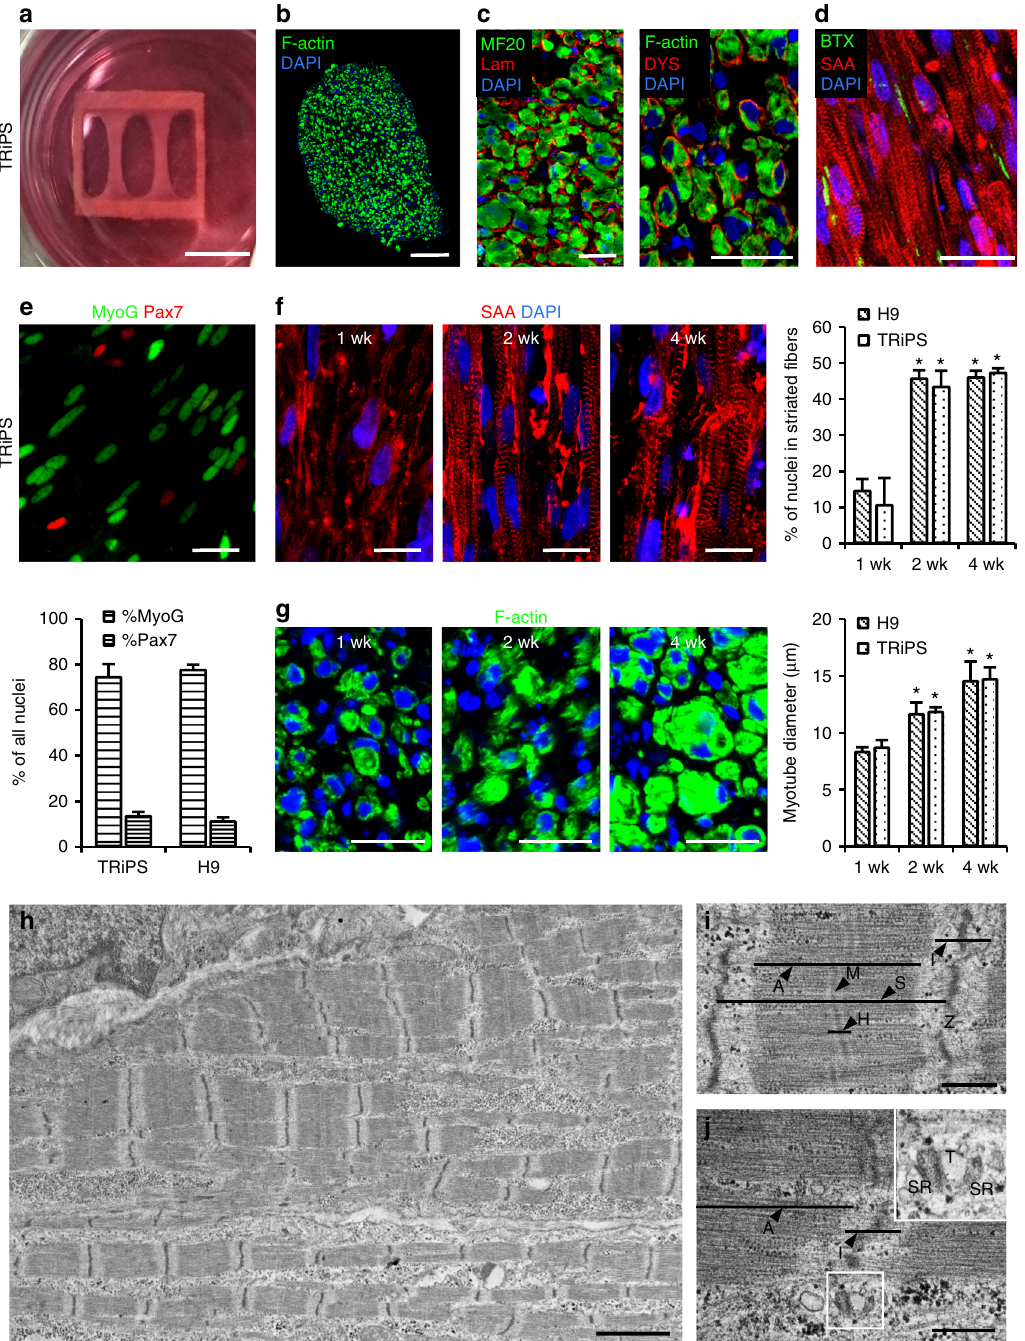
Fig. 3 Structure of hPSC-derived iSKM bundles. a A 2-week differentiated iSKM bundle pair anchored within a nylon frame. Scale bar = 5 mm. b , c Representative immunostaining of dense, uniformly distributed, myotubes in bundle cross-section. Scale bars: ( b ) 75 µ m, ( c ) 25 µ m. Lam laminin, DYS Dystrophin. d Representative longitudinal section of 2-week differentiated bundles showing aligned, cross-striated myotubes with α -bungarotoxin (BTX) labeled acetylcholine receptors. Scale bar = 25 µ m. e Immunostaining and quanti fi cation of Pax7 + and MyoG + nuclei in 2-week H9 and TRiPS bundles ( n = 3 bundles for each cell line). Scale bar = 25 µ m. f Immunostaining and quanti fi cation of cross-striated myotubes ( n = 3 bundles for each cell line, * P < 0.05